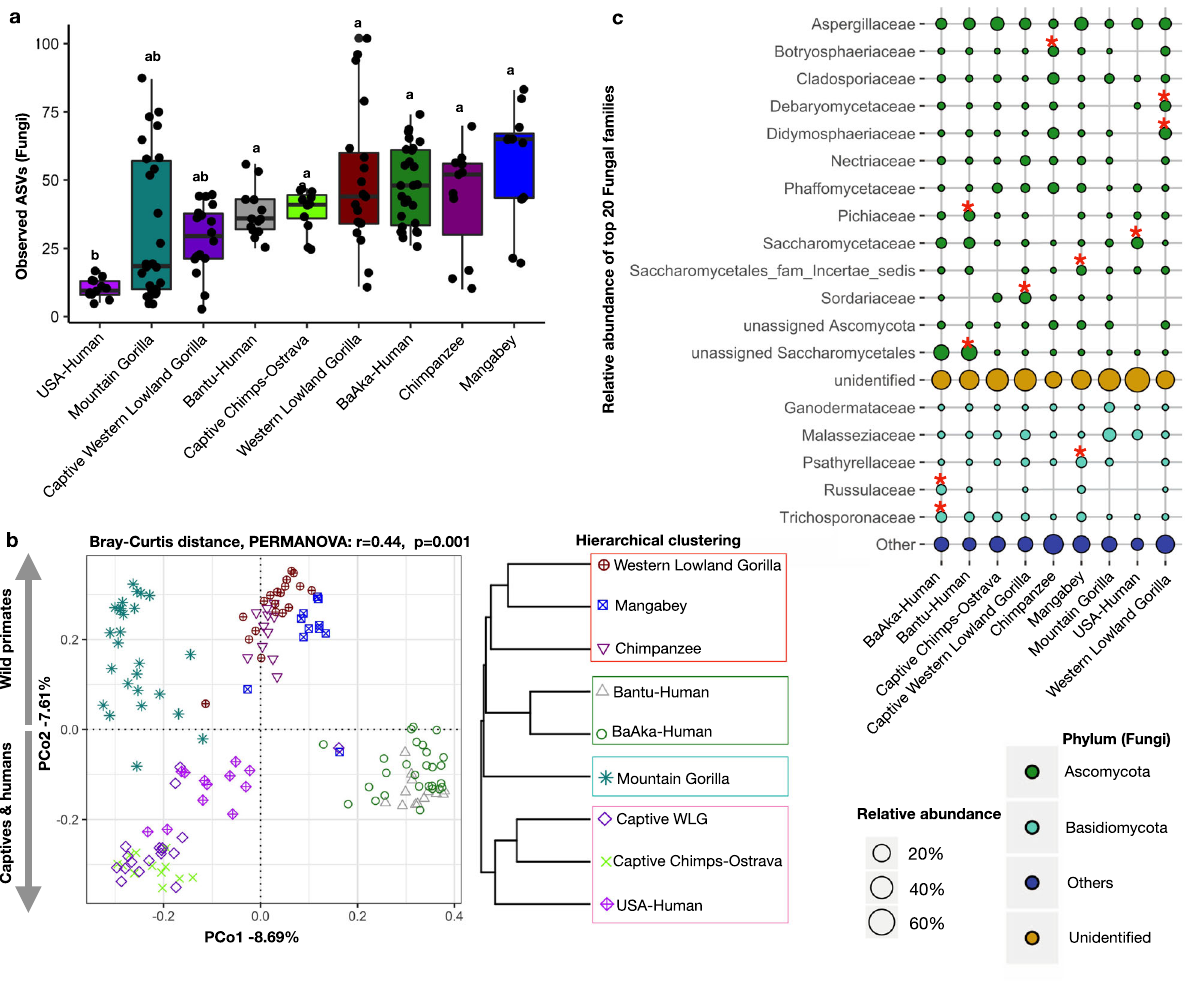
Fig. 1 Gut mycobiome composition differs based on subsistence strategy across different primates. a Alpha diversity analysis showing lower fungal richness in US humans, compared with other primate populations. b Principal coordinate analysis based on Bray-Curtis distances showing different fungal community composition across different primate groups. Each symbol represents mycobiome composition, at the ASV level, in the fecal samples of an individual primate. A Bray-Curtis distance dendrogram (hierarchical clustering, average distances) based on average fungal ASV abundances showed similarities between phylogenetically distinct primate groups. Each group with similar mycobiome composition is shown to re fl ect PAM clustering (Supplementary Fig. 2). c Relative abundance of top 20 fungal families and their mean distribution among different primate groups are shown in a Bubble plot. Color code represents membership of each family to a speci fi c Fungal Phylum. Differentially abundant taxa (Supplementary Table 1) were identi fi ed using Indicator Species Analysis and the families marked with stars are representative of a given primate group. The identi fi ers used for primate groups are Western Lowland Gorilla: WLG, Mangabey: Agile Mangabeys and Chimps: Chimpanzee. In boxplots, center values indicate the median; bounds of box represents lower/upper quartiles; whiskers show inner